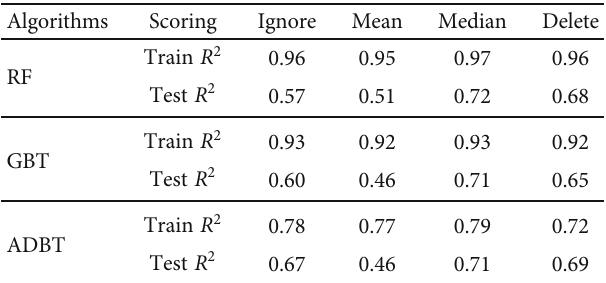
Table 1: R 2 of RF model under di ff erent outlier processing